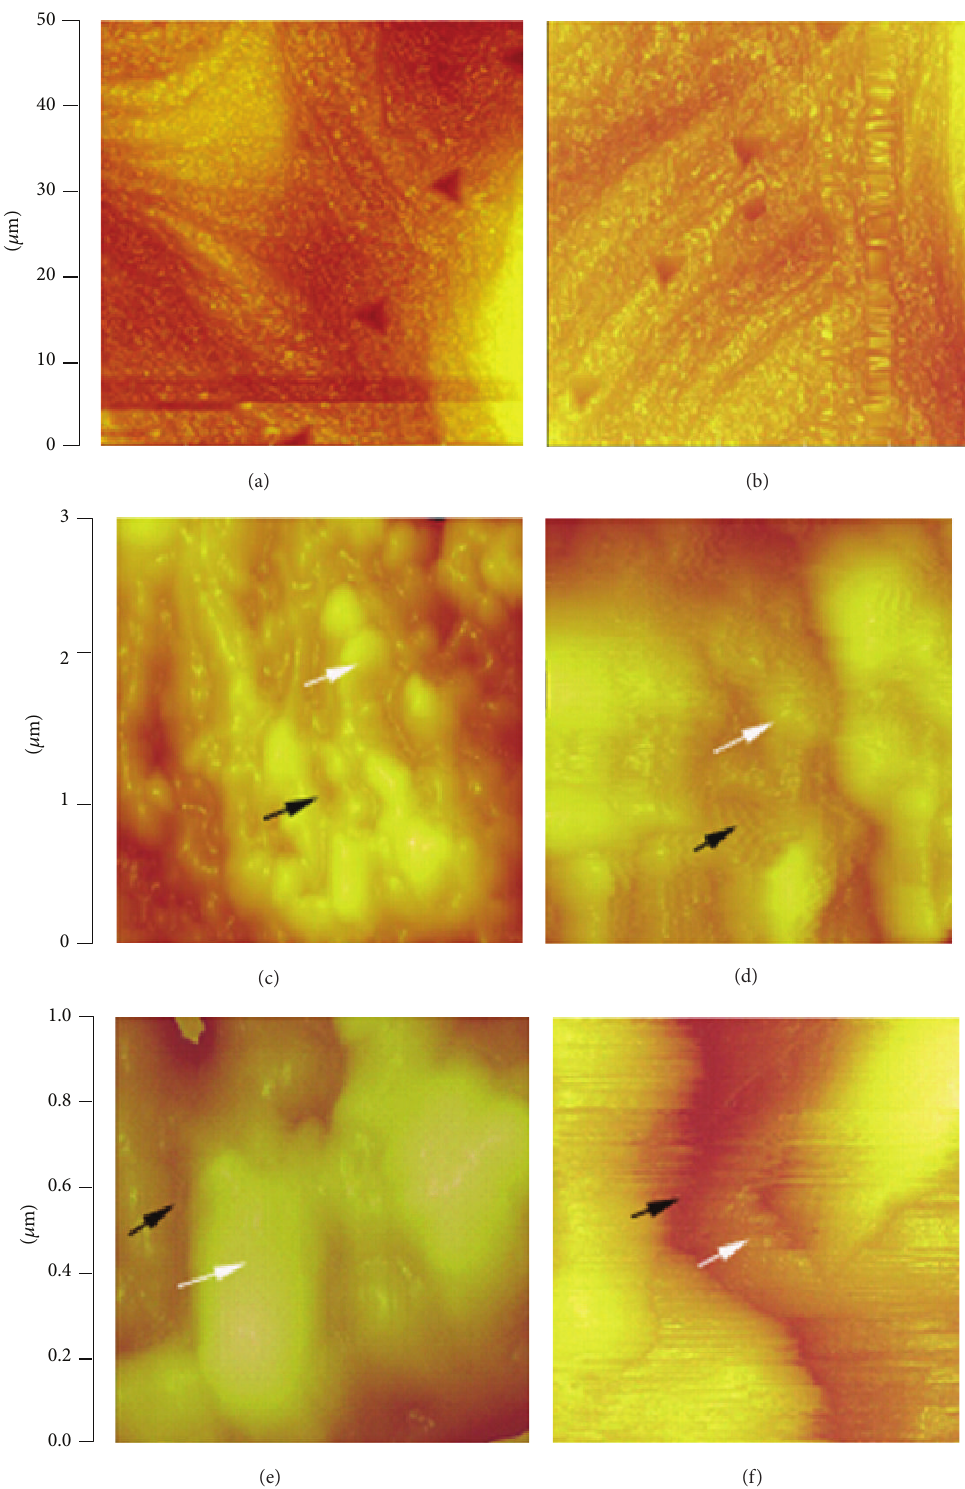
Figure 4: Typical atomic force microscopic topography of trabeculae of rat vertebral bodies of sham operated rats (left panel) and ovariectomizedrats(rightpanel).Thetop2images(a,b)showunindentedsurfaceandindentedimpression.Themiddle2imagesdemonstrate rough surface with many nodules closely packed to each other in sham operation (c), and relatively smooth surface characterized by some loosely packed large nodular structures in ovariectomized rat (d). The woven collagen fibrils of trabeculae from different group of animals have different directions. The interfibrillar space between collagen fibrils of a sham operated rat is more compacted (e), while ovariectomy results in larger size composite of collagen and mineral crystals